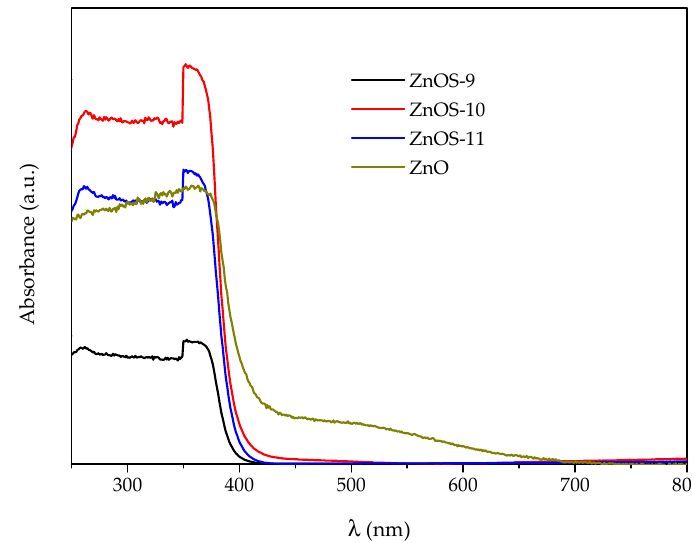
Figure 4. UV-vis absorption spectra for the as-synthesized ZnOS heterostructures and ZnO.